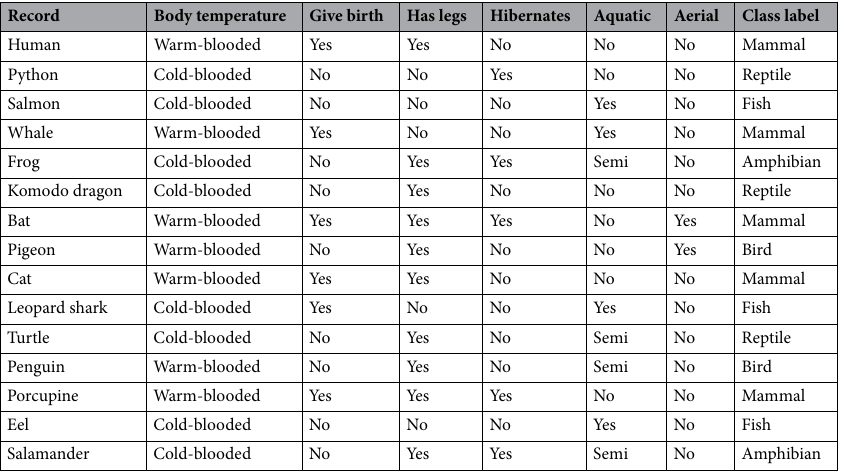
Table 1. The training data set corresponding to vertebrates extracted from: https ://docpl ayer.net/42646 00-Class ifica tion-basic -conce pts-decis ion-trees -and-model -evalu ation .html.